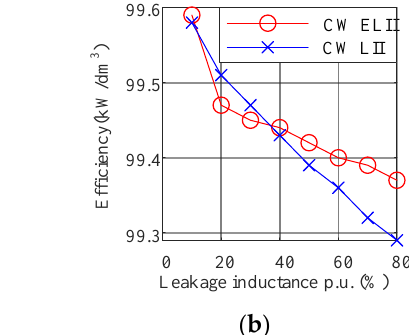
( h ) Figure 21. Pareto fronts of CW LII and CW ELII solutions with different leakage inductances. ( a – h ) leakage inductance: 10% p.u. to 80% p.u. (40 μH to 320 μH).